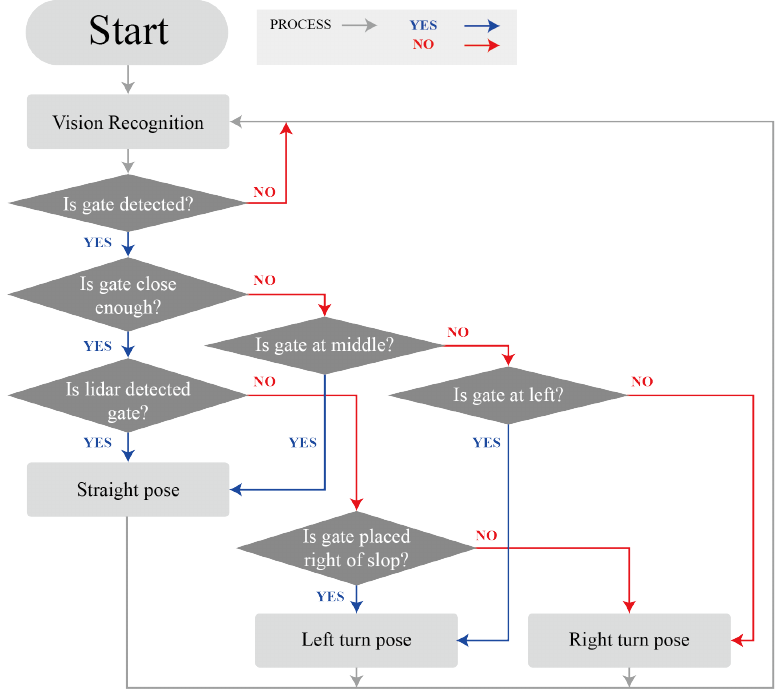
Figure 11. Flow chart for DIANA